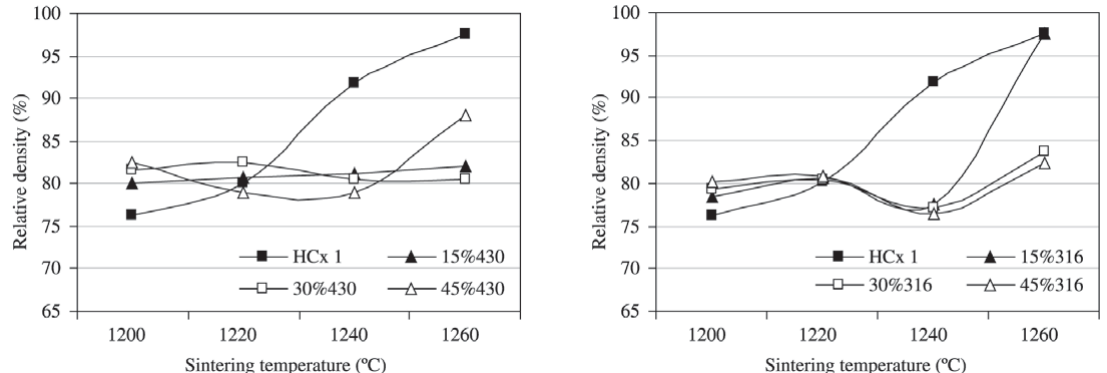
Figure 3. Relative density of diluted materials vs. sintering